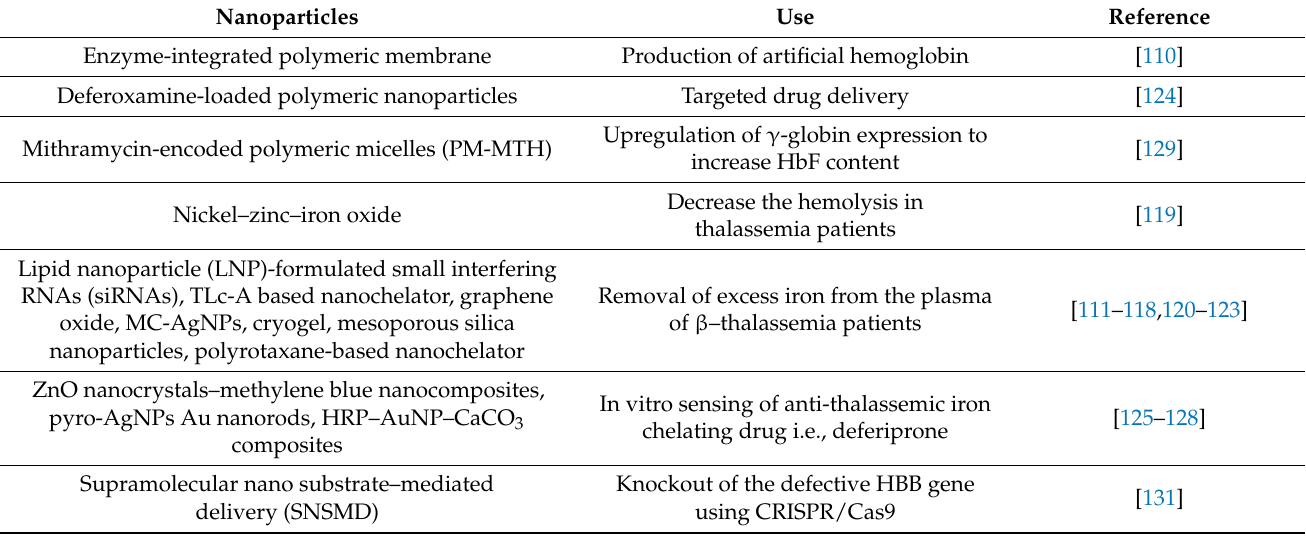
Table 3. Nanotechnology-based therapeutic applications for thalassemia